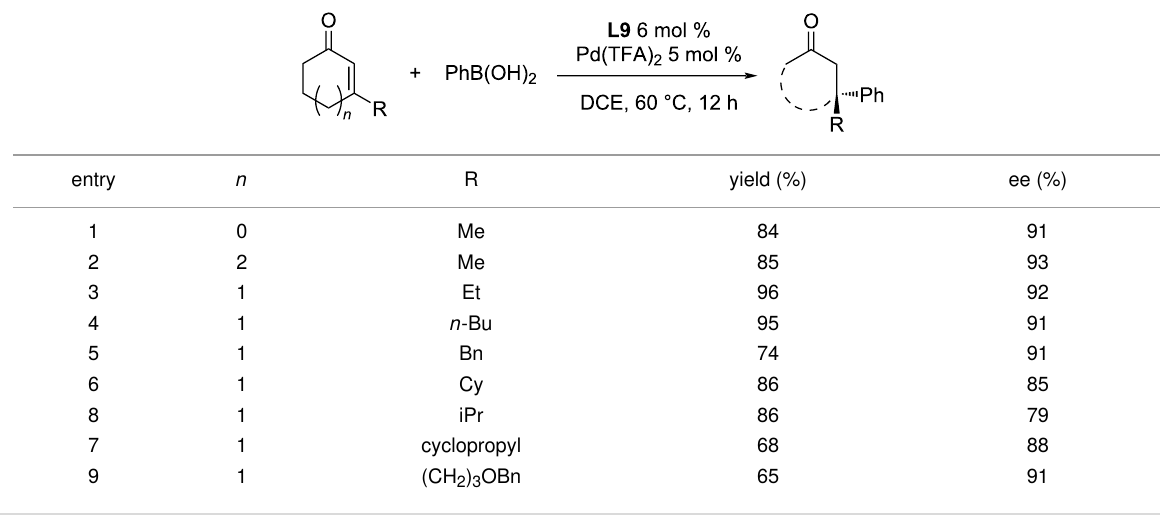
Table 18: Addition reactions of phenylboronic acid to various 3-substituted enones catalysed by L9 /Pd(TFA) 2